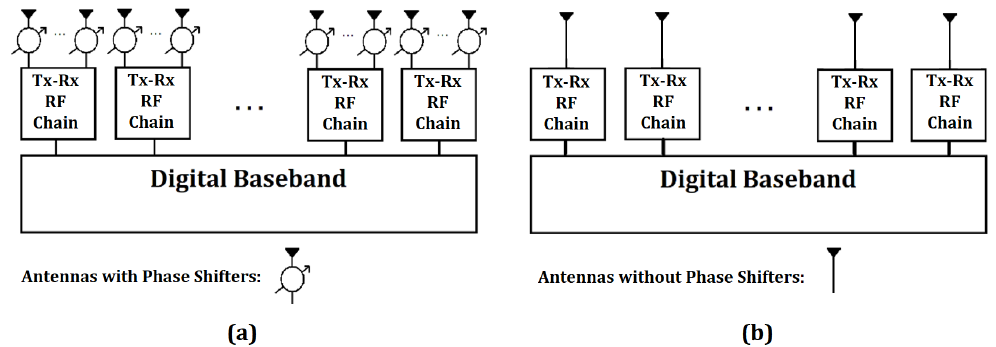
Figure 1. ( a ) Example hybrid architecture. Each RF chain sends the same signal to multiple connected antennas, altered only by phase shifters. ( b ) Example fully digital architecture. Every antenna has its own RF chain attached, allowing for more complete signal control but increasing hardware